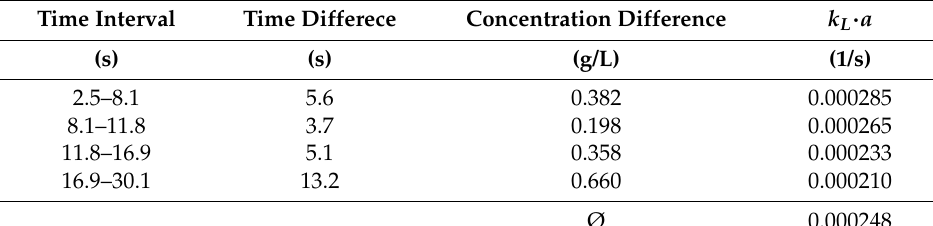
Figure 4. Drop concentration at varying residence times (butyl acetate (d)–solid-liquid extraction (SLE) extract (c)). Table 1. Determination of the k L · a value for artemisinin from Solid-liquid extraction (SLE) extract (c) in butyl acetate (d).